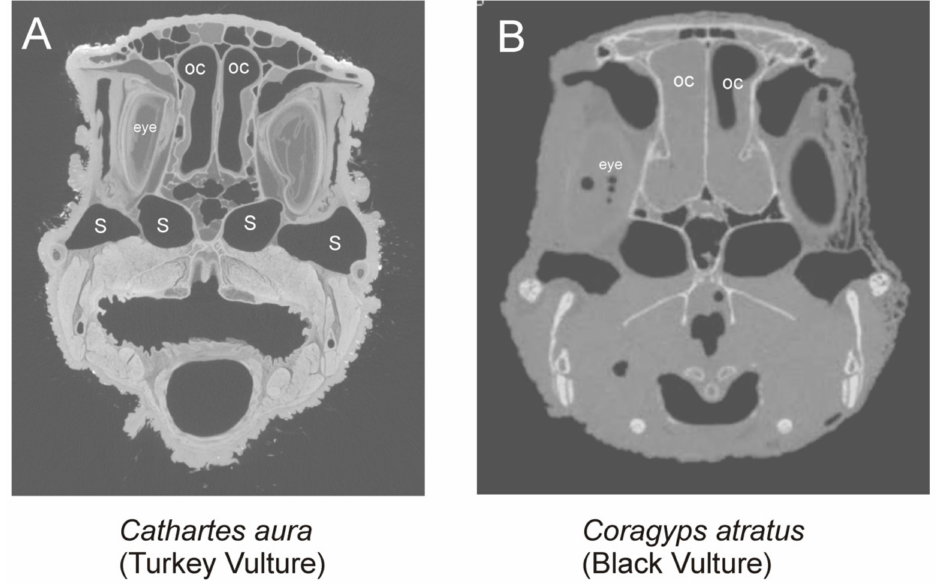
Figure 11. Axial CT sections of olfactory chambers of vultures. ( A ), Cathartes aura, Turkey Vulture, ( B ), Coragyps atratus, Black Vulture. oc, olfactory chamber; s,